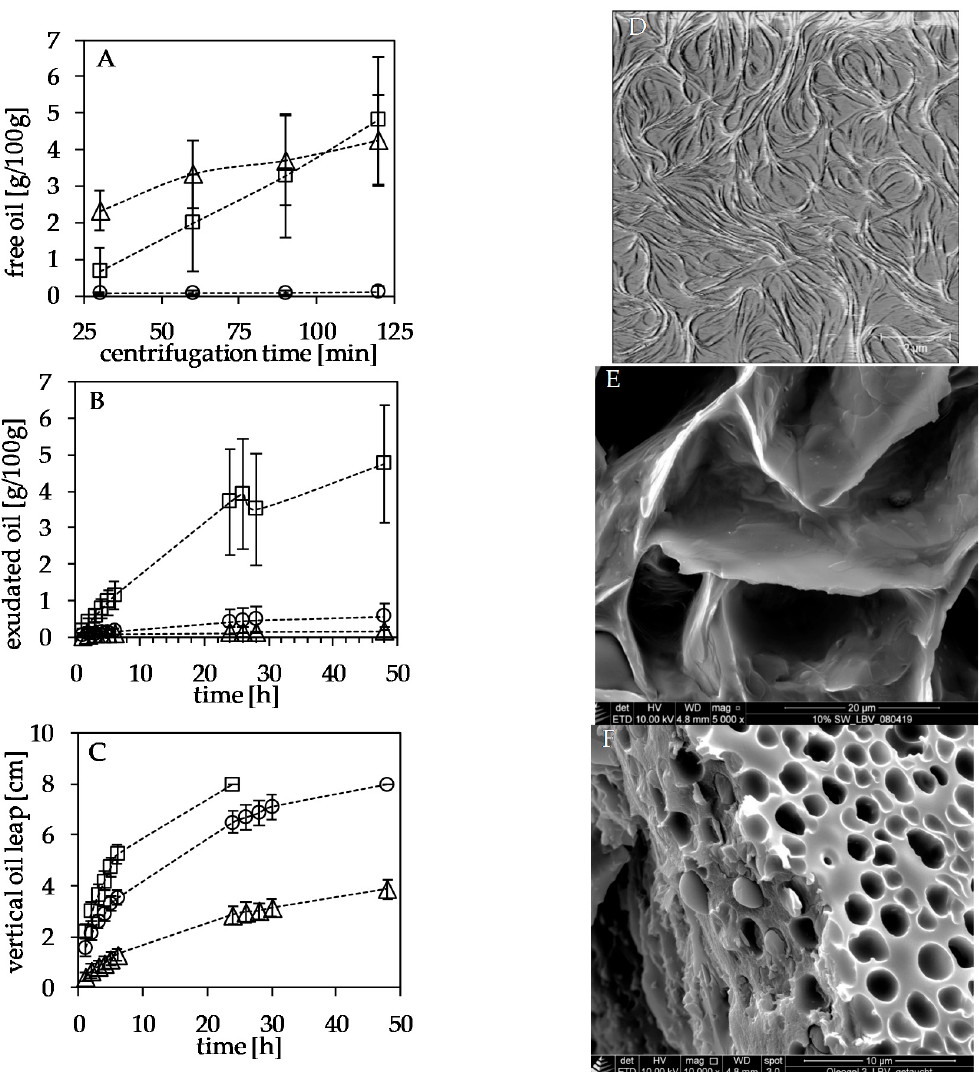
Figure 7. Left: Comparison of different methods to determine oil-binding capacity (OBC): oil exuded as function of time for 10% ( w / w ) structurant in canola oil oleogels. ( A ) Conventional centrifugation test (time in minutes), ( B ) filter-paper method block on paper (time in hours), ( C ) filter-paper climb method (time in hours) [66]. Symbols: squares: ethylcellulose, triangles: 1:1 sitosterol/oryzanol, circles: SFX. For details of the experimental procedure, see [66]. Right micrographs of oleogels: ( D ) atomic force microscopy sitosterol/oryzanol (scale bar 2µm), ( E ) cryo-SEM image of SFX (scale bar 20 µm), ( F ) cryo-SEM image of ethylcellulose (scale bar 10 µm).